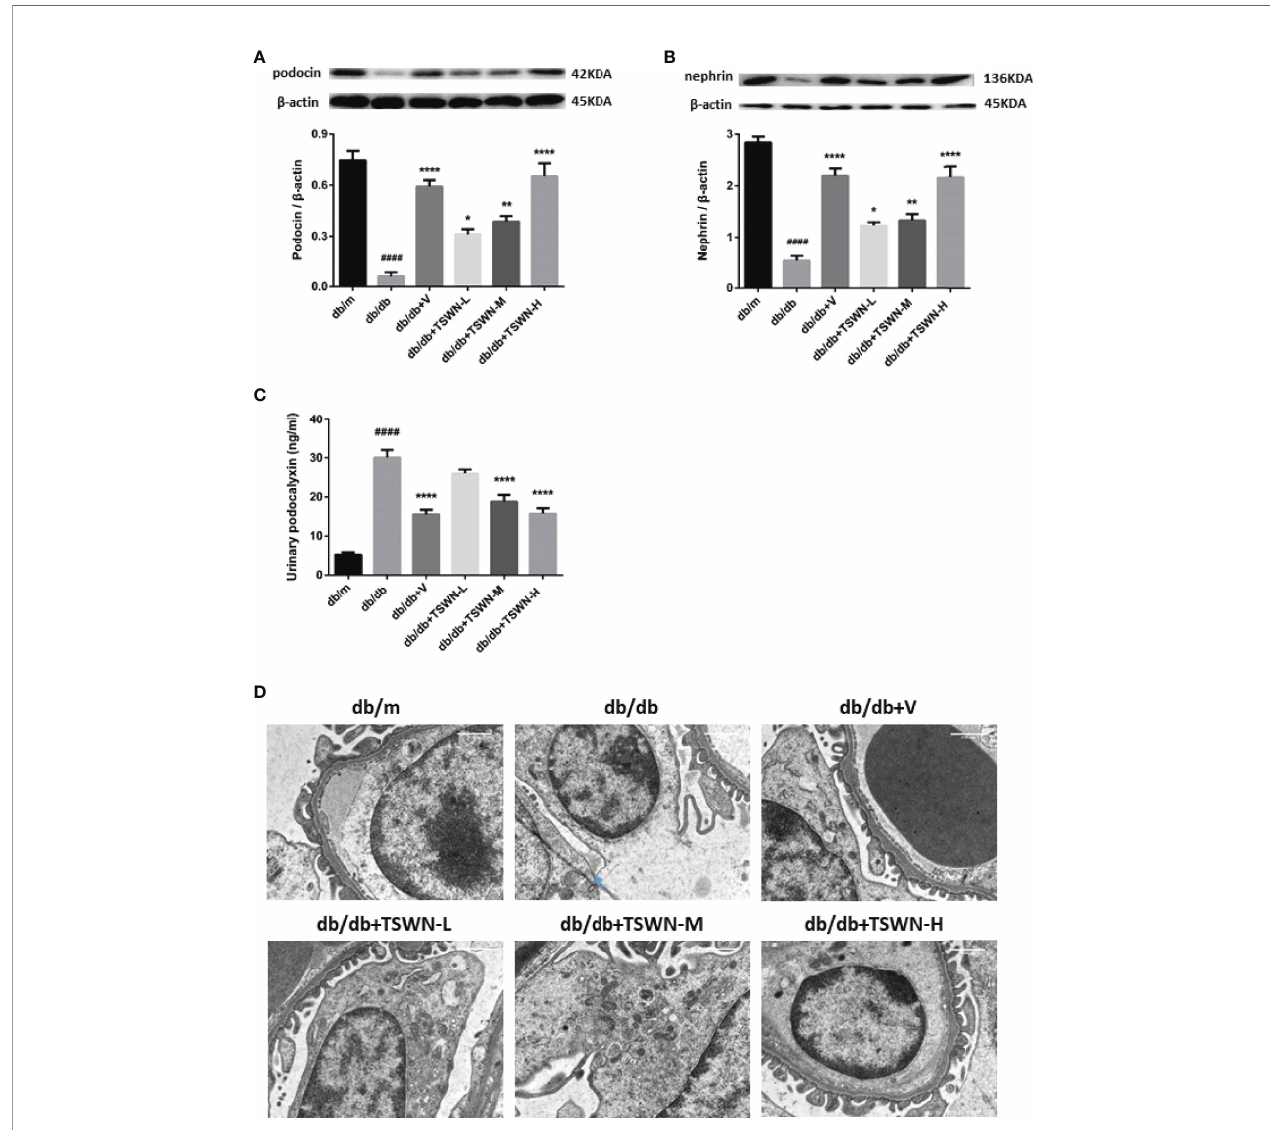
FIGURE 6 | Podocytes in mouse kidneys. (A) Representative photographs and quanti fi cation of podocin in mouse kidneys measured by western blot. (B) Representative photographs and quanti fi cation of nephrin in mouse kidneys measured by western blot. (C) Quanti fi cation of urinary podocalyxin measured by enzyme linked immunosorbent assay (ELISA). (D) Representative photographs of podocytes in mouse kidneys detected by transmission electron microscopy. n = 6 mice/group. #### P < 0.0001 vs db/m group; *P < 0.05, **P < 0.01, ****P < 0.0001 vs db/db group. Db/m, db/m mice; db/db, db/db mice; db/db+V, db/db mice with valsartan treatment; db/db+TSWN-L, db/db mice with low dose TSWN treatment; db/db+TSWN-M, db/db mice with middle dose TSWN treatment; db/db+TSWN-H, db/db mice with high dose TSWN treatment. Data are means ±